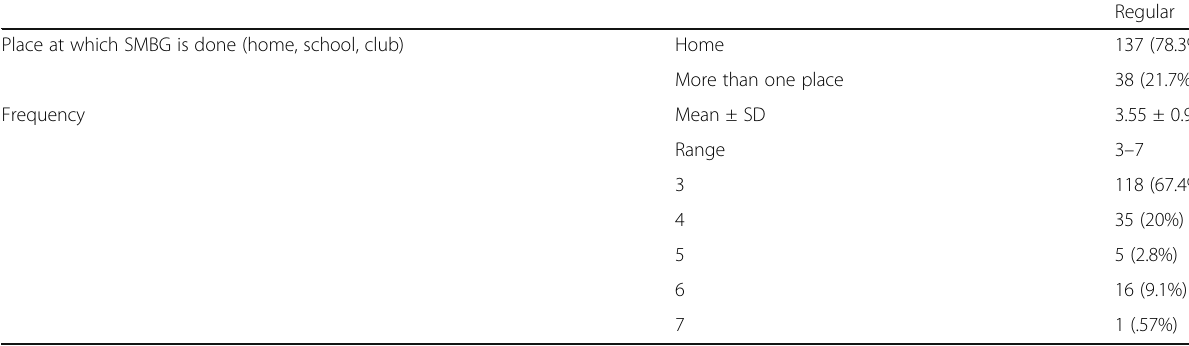
Table 3 Frequency of SMBG in type 1 diabetic patients Place at which SMBG is done (home, school,